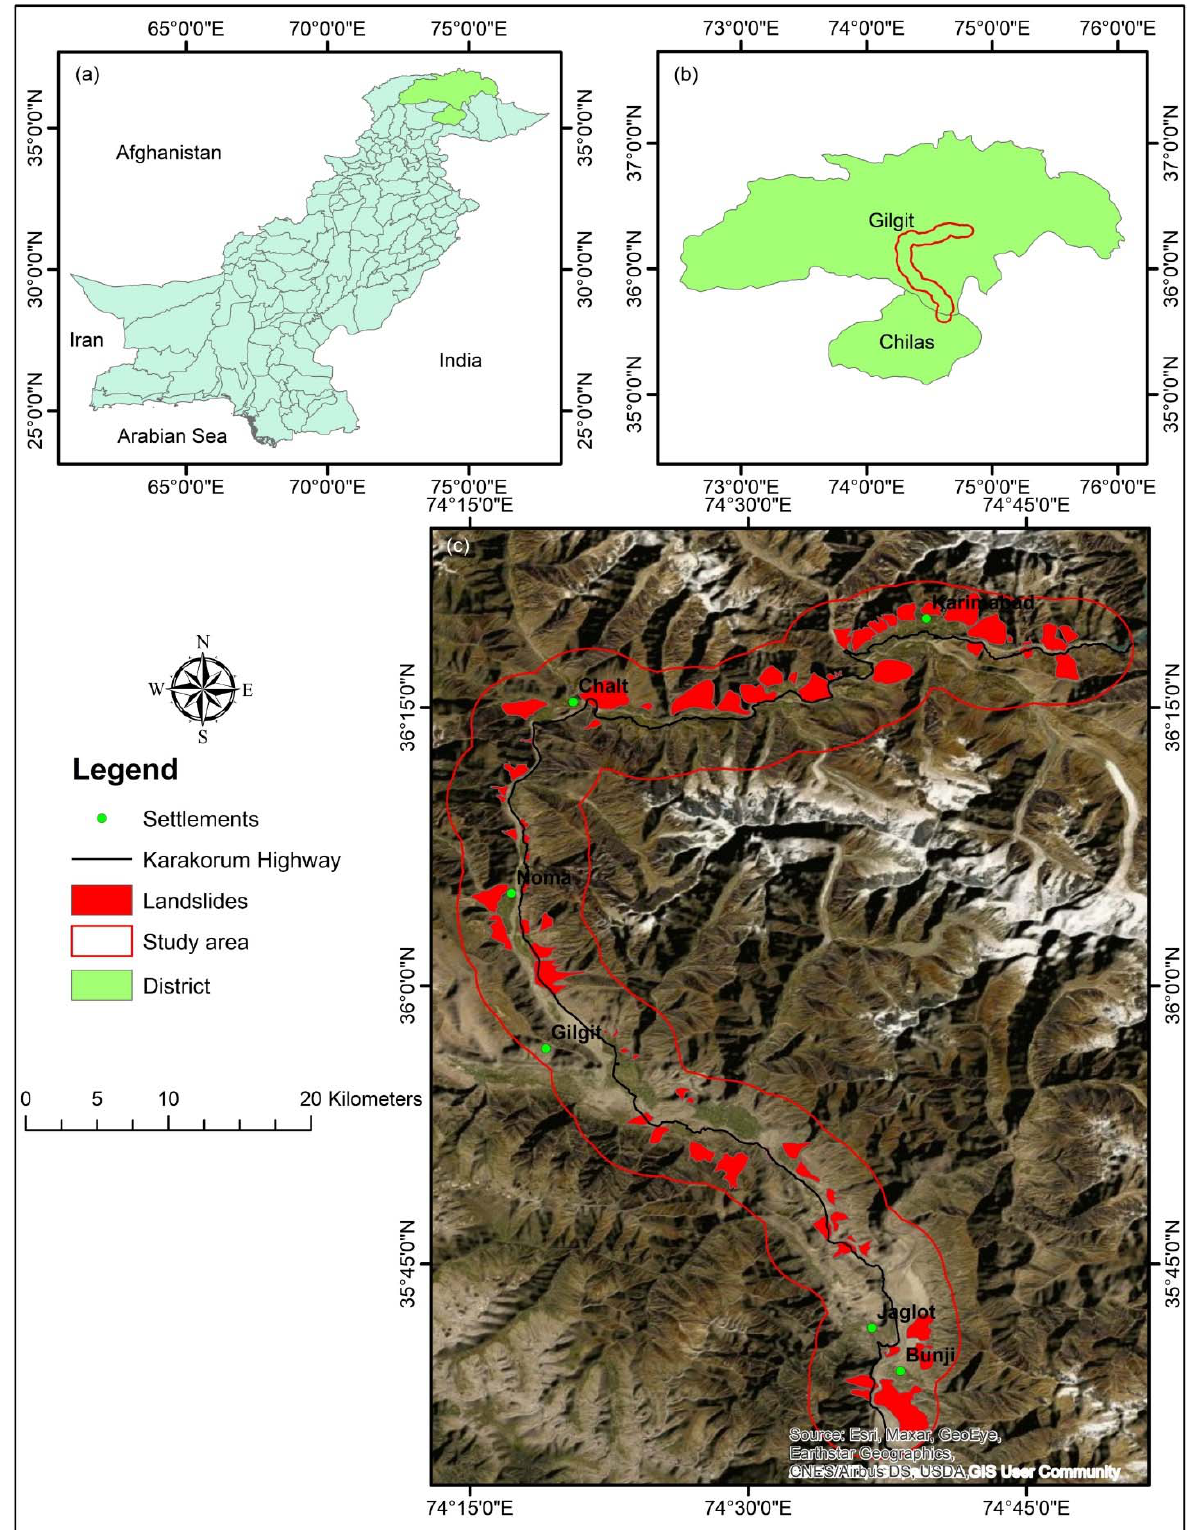
Figure 1. Location map of the research area. ( a ) Pakistan. ( b ) District boundaries of Gilgit and Chilas. ( c ) Remote sensing image; study area in black outline.